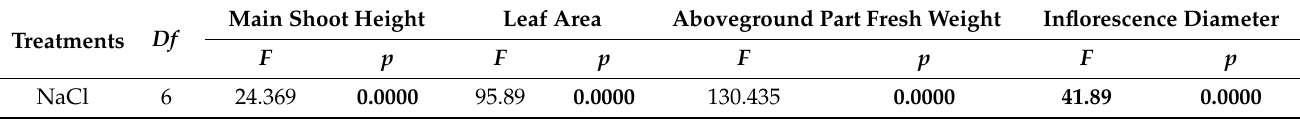
Table 1. One-way ANOVA results for the effect of salt doses on growth parameters. Main Shoot Height Leaf Area Aboveground Part Fresh Weight Inflorescence Treatments Df